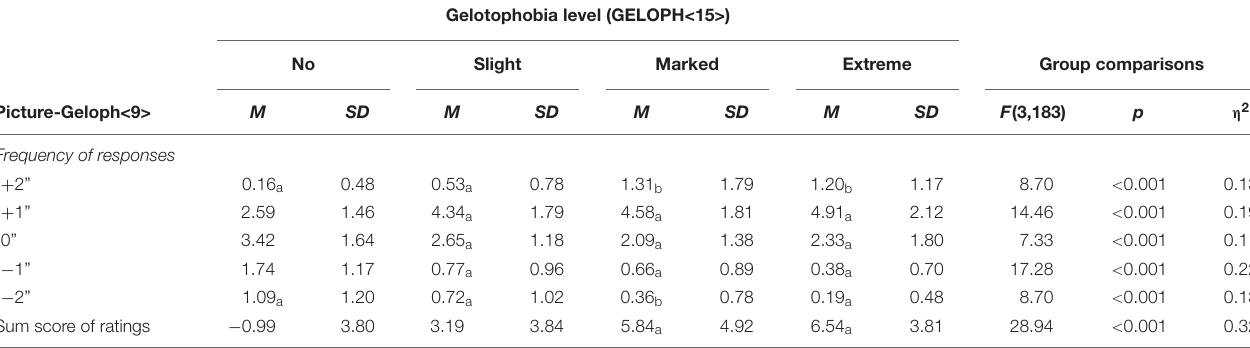
TABLE 6 | Frequency of types of responses and the sum score of the Picture-Geloph<9> as a function of level of gelotophobia (Study 2; Sample 2 and Sample 3